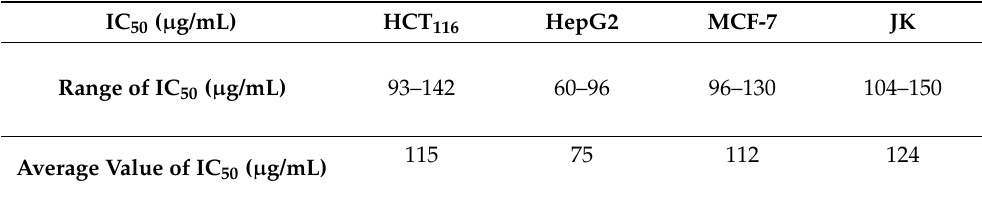
Figure 1. The percentage of cell viability at various concentrations of J. procera methanolic extract after 48 h of treatment. Table 1. The IC 50 of J. procera methanolic extract in HCT 116 , HepG2, MCF-7, and JK after 48